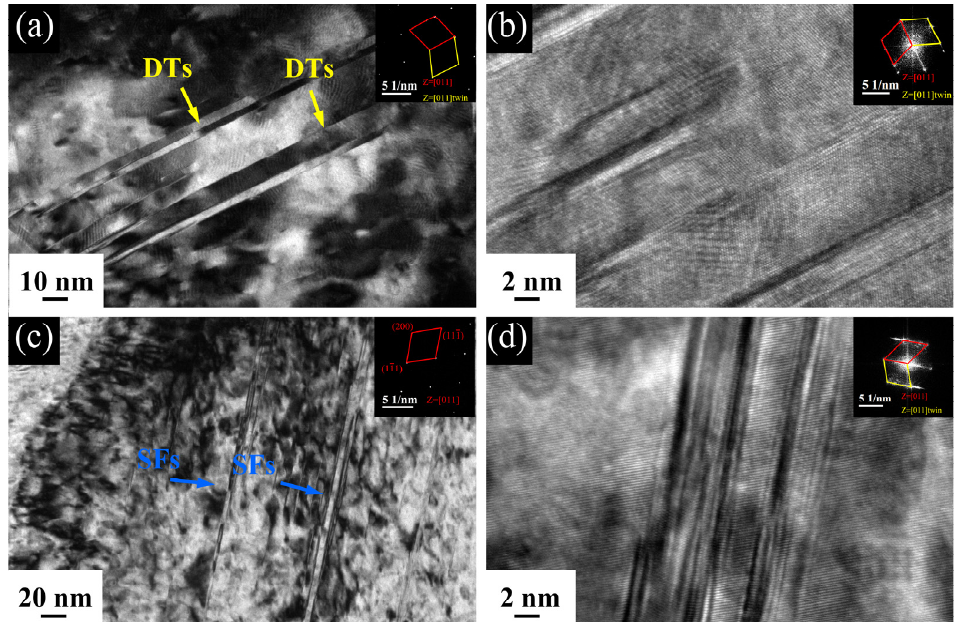
Figure 7. ( a ) BF ‐ TEM micrograph showing the presence of deformation twins (inset is the corre ‐ sponding SAED pattern of fcc–twin relationship); ( b ) HR ‐ TEM image showing the fcc–twin struc ‐ ture; ( c ) BF ‐ TEM micrograph of SFs (inset SAED confirms these SFs have not transformed into an hcp phase); ( d ) HRTEM of SFs in the tensile ‐ fractured 5Al ‐ 1123 K